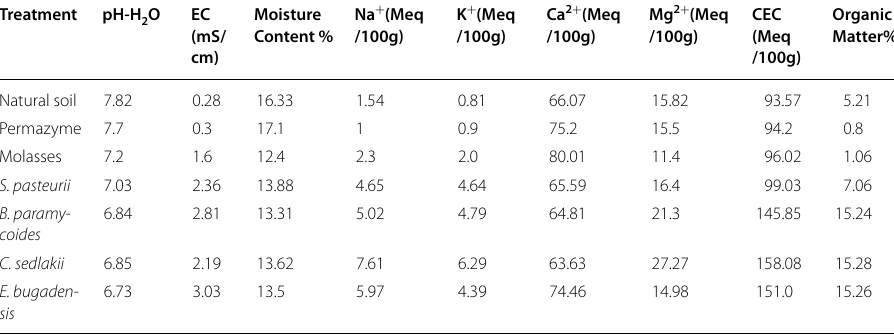
EC electrical conductivity, CEC cation exchange capacity